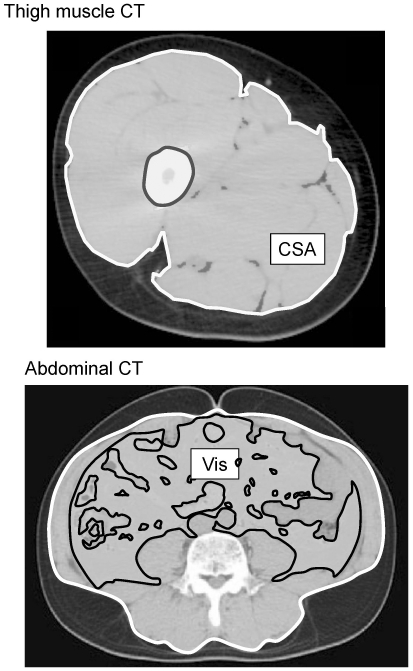
Thigh muscle CT (top) at the mid-thigh level and abdominal CT (bottom) at umbilicus level.Thigh muscle cross-sectional area (CAS) and visceral fat area (Vis) were obtained.